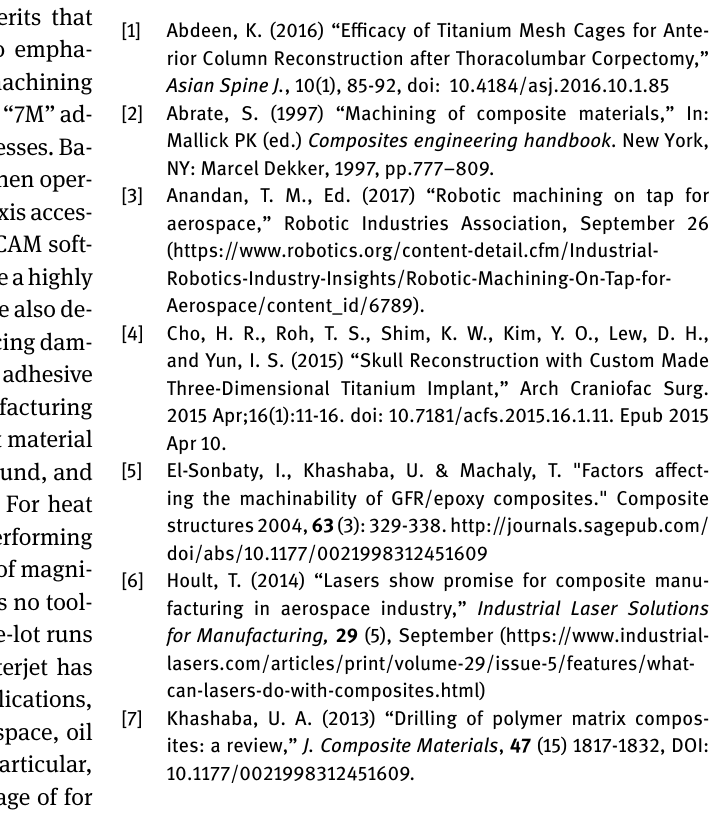
cesses to sterilize the implants are expected to be the most labor intensive and time consuming. 7